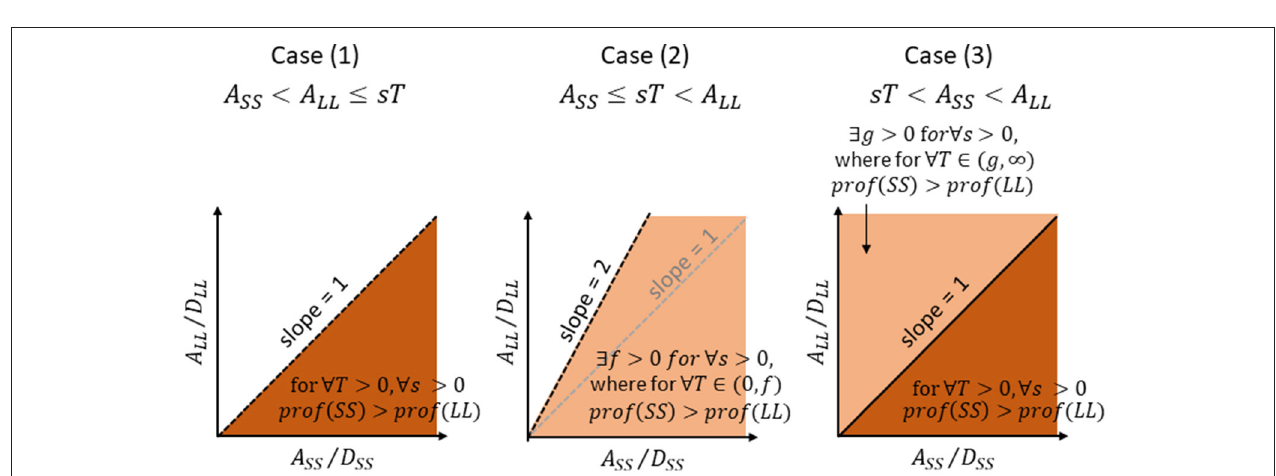
FIGURE 2 | (A) A group comprising two opportunistic foragers is assumed. Each of the two foragers searches for food, and if one finds food (F), it acts a producing individual (P). Another forager immediately detects the discovery and rushes to P as a scrounging individual (S). A food patch of finite amount ( A ) is placed at a long distance ( d ) from P, representing the LL option (left columns). A food patch of a smaller amount at a short distance represents the SS option (right columns). (B) We consider three levels of scrounging as long [ B a; Case (1)], intermediate [ B b; Case (2)] and short [ B c; Case (3)] distances between P and S ( δ ). In Case (1), scrounging does not occur for both LL and SS. In Case (2), scrounging occurs only for LL. In Case (3), scrounging occur for both LL and SS. Scrounging inevitably reduces the P’s finder’s share, or the time during which P monopolizes the food ( T ).